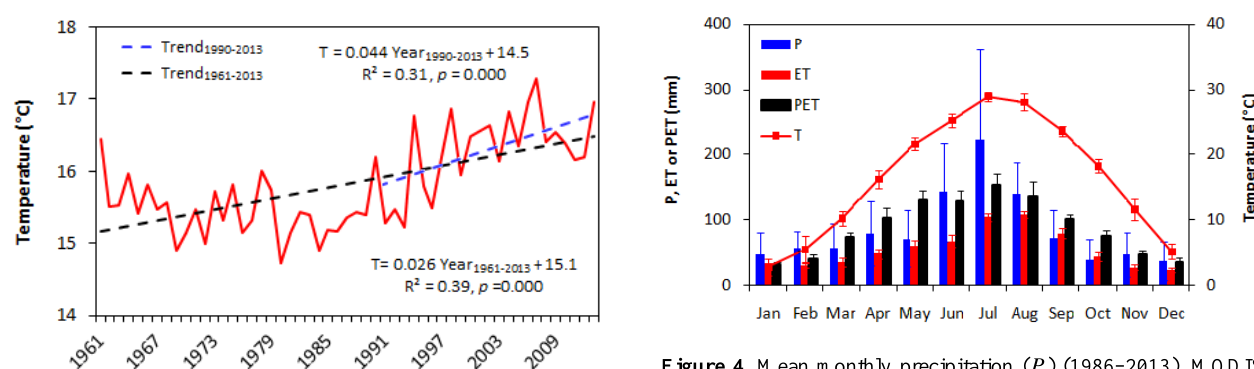
Figure 4. Mean monthly precipitation ( P ) (1986–2013), MODIS evapotranspiration (ET) (2000–2013), potential evapotranspiration (PET) (2000–2013) and temperature ( T ) (1986–2013). The vertical lines show standard